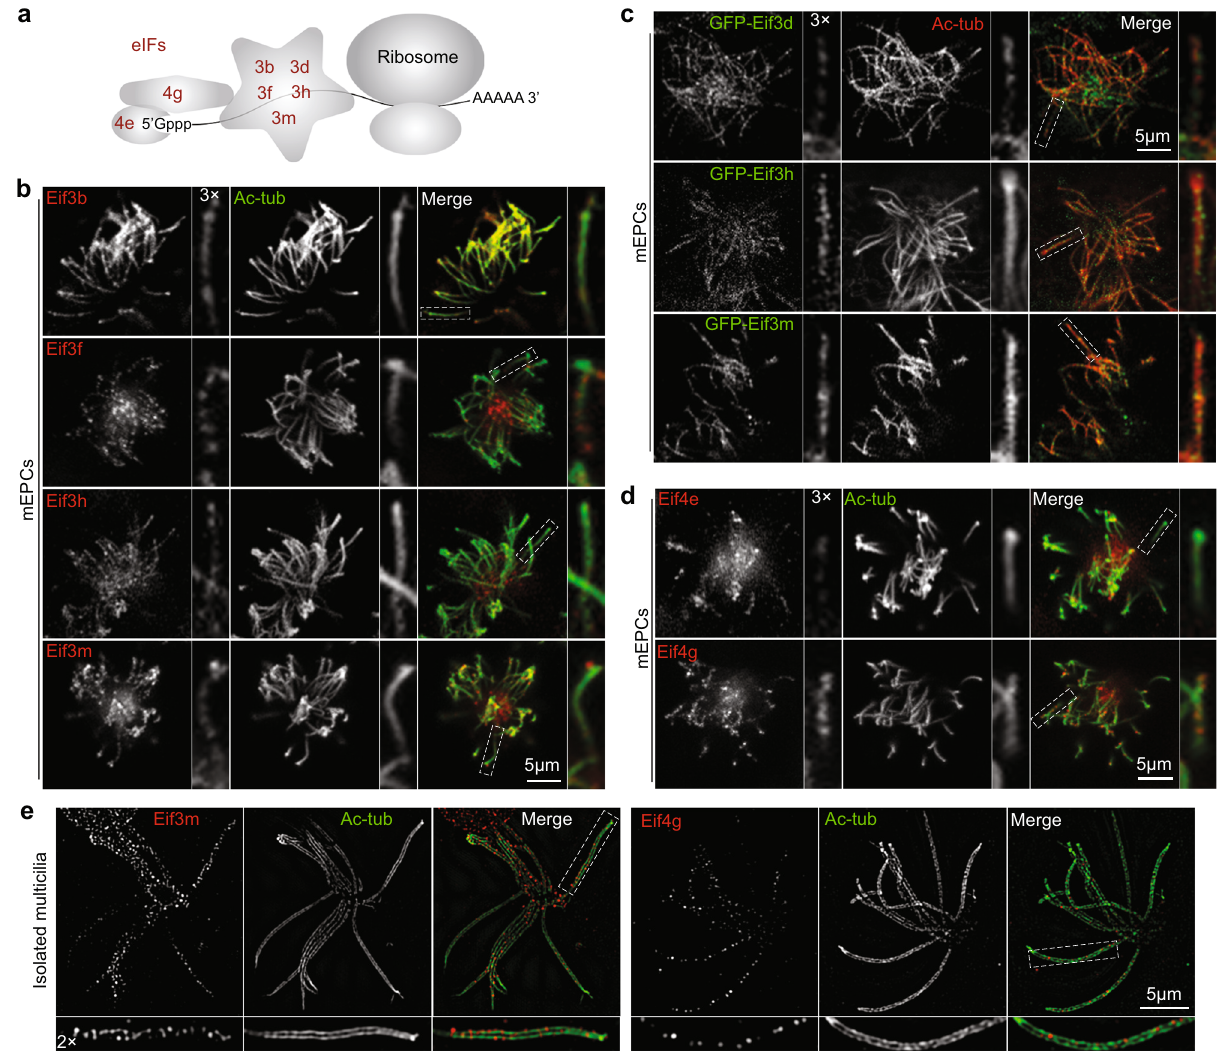
Fig. 2 Ependymal multicilia contain eIF components. a Diagrams illustrating locations of investigated eIFs. b Ciliary localization of endogenous Eif3 components in day-10 mEPCs. Typical cilia were magni fi ed to show details. Ac-tub labeled axonemes. c Ciliary localization of GFP-tagged Eif3 components. Cultured mEPCs were infected with lentiviral particles at day − 1 to express GFP-fusion proteins and fi xed at day 10 for immunostaining. d Ciliary localizations of endogenous Eif4E and Eif4G. e Ciliary localization of Eif3m and Eif4g. Isolated multicilia were imaged under three-dimensional structured illumination microscopy